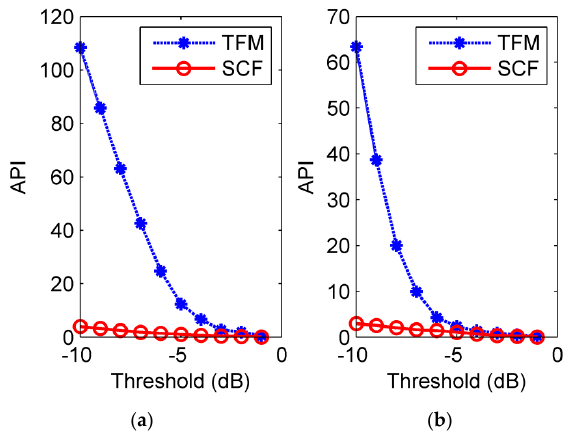
Figure 12. The dependence of the array performance indicator (API) on the different threshold value for ( a ) specimen 1 and ( b ) specimen 2.